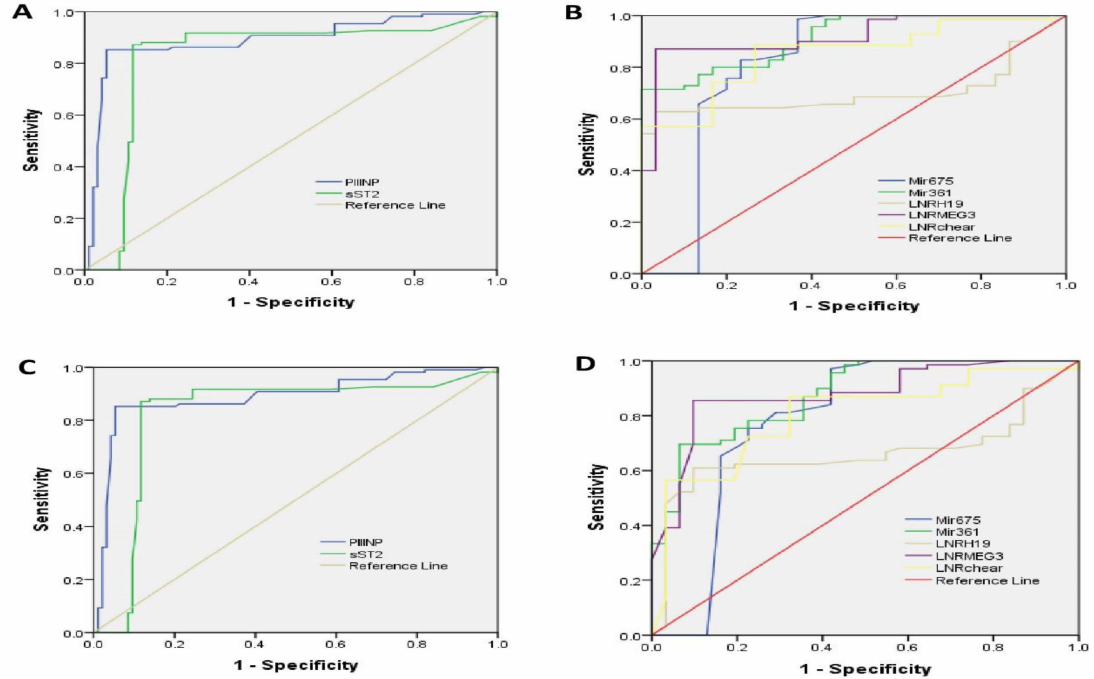
Figure 4. Receiver Operating Characteristic curves (ROC) for investigation of cardiac Bi-omarkers ( A ) and ncRNA ( B ) in heart failure predication among acute coronary syndrome (ACS) patients as well as of cardiac Biomarkers ( C ) and ncRNA ( D ) in major acute cardiovascular events (MACE) predication among ACS